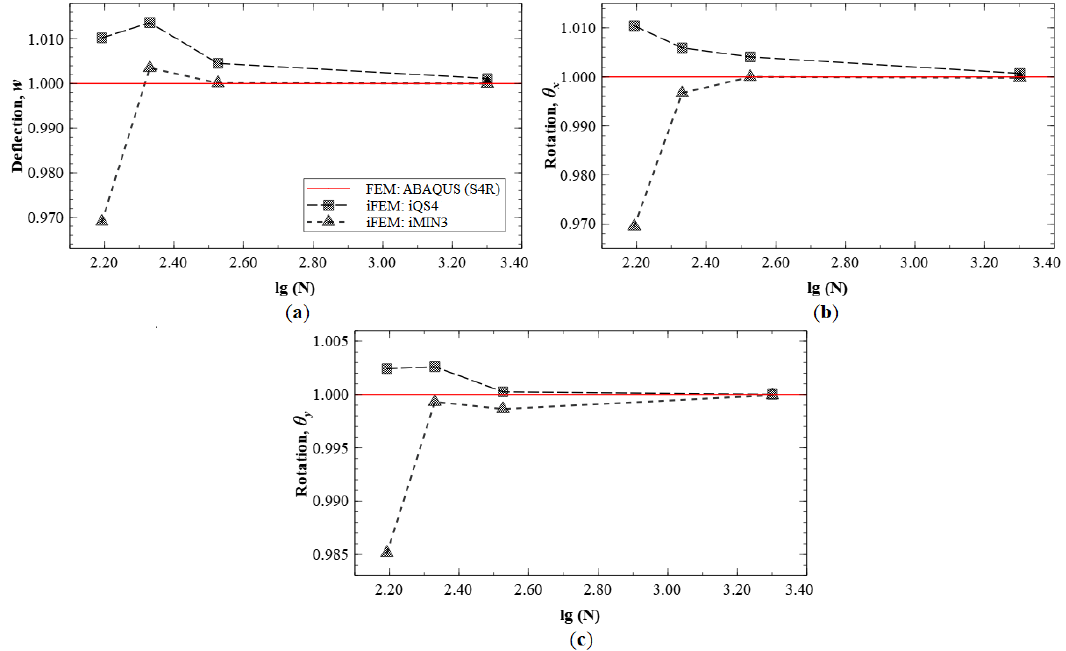
Figure 20. iFEM results for Mode 5: convergence plots for ( a ) w , ( b ) 𝜃 𝑥 , and ( c ) 𝜃 𝑦 .